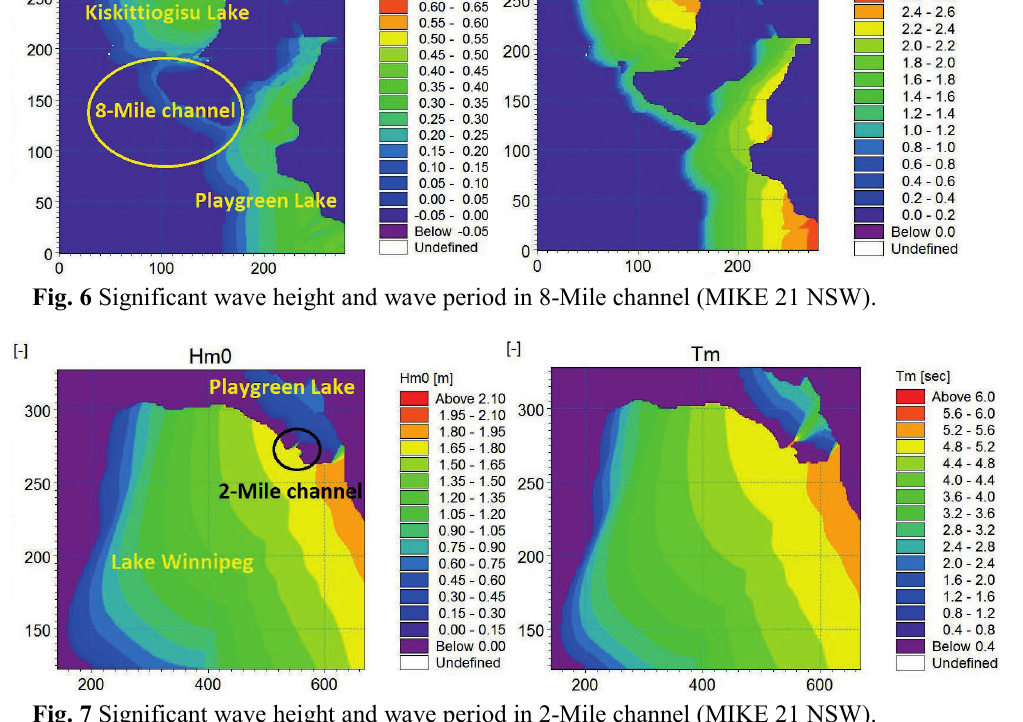
Fig. 7 Significant wave height and wave period in 2-Mile channel (MIKE 21 NSW).